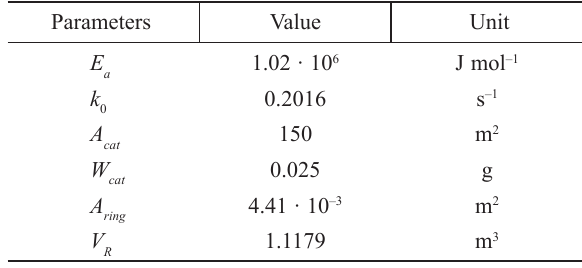
Table 2 – Simulation conditions